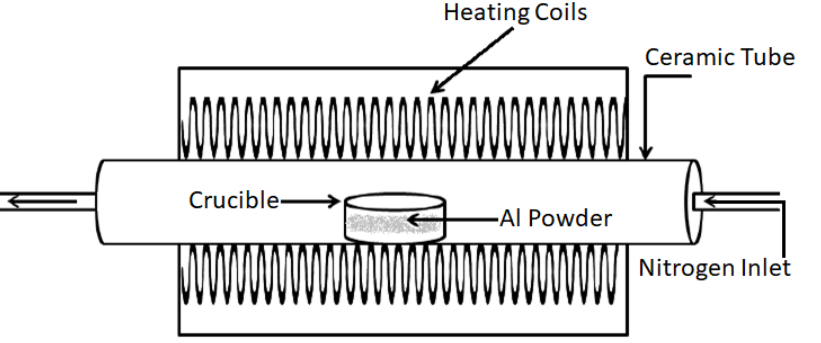
Figure 2. Schematic showing the setup for the low-temperature nitriding of Al + 1 wt.% Mg powder using a horizontal tube furnace equipped with a high-purity nitrogen feed